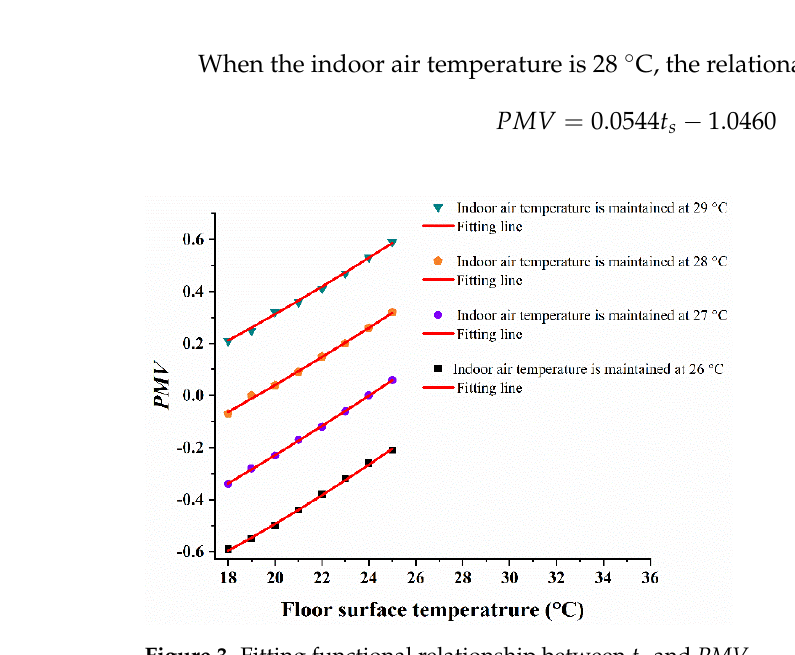
Figure 3. Fitting functional relationship between t s and PMV